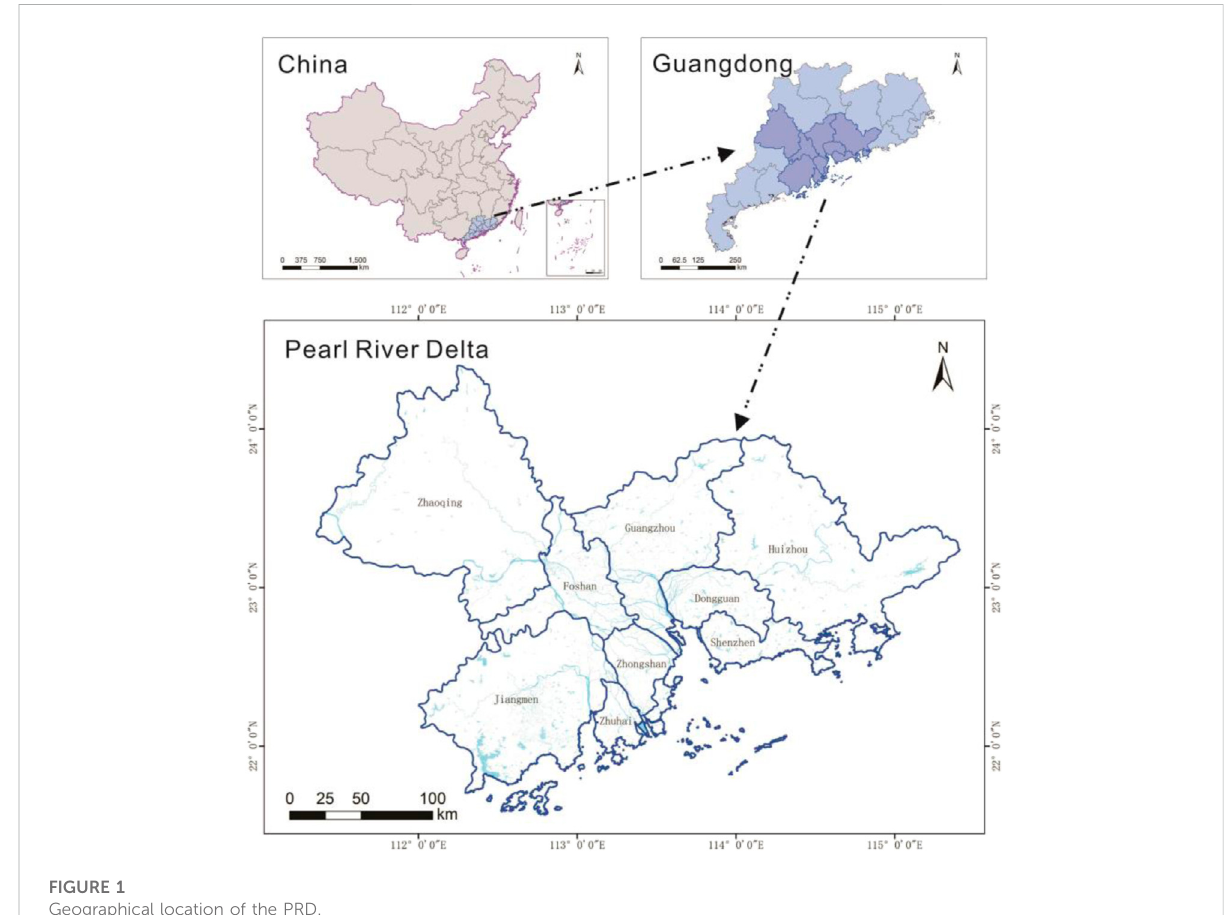
FIGURE 1 Geographical location of the